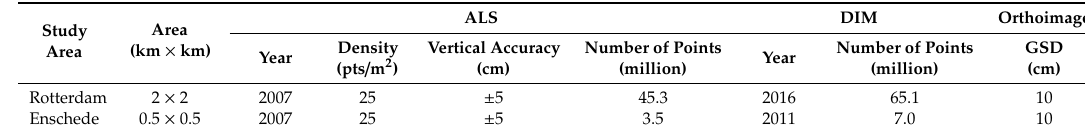
Table 1. Specifications of two study areas.